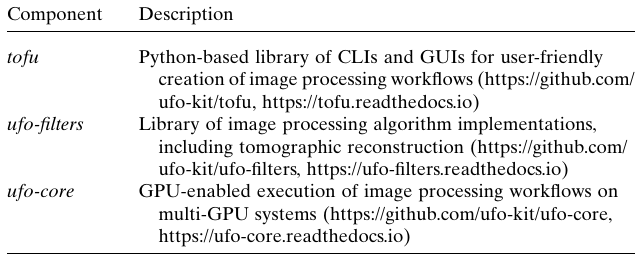
Table 1 Tofu software stack. Component Description